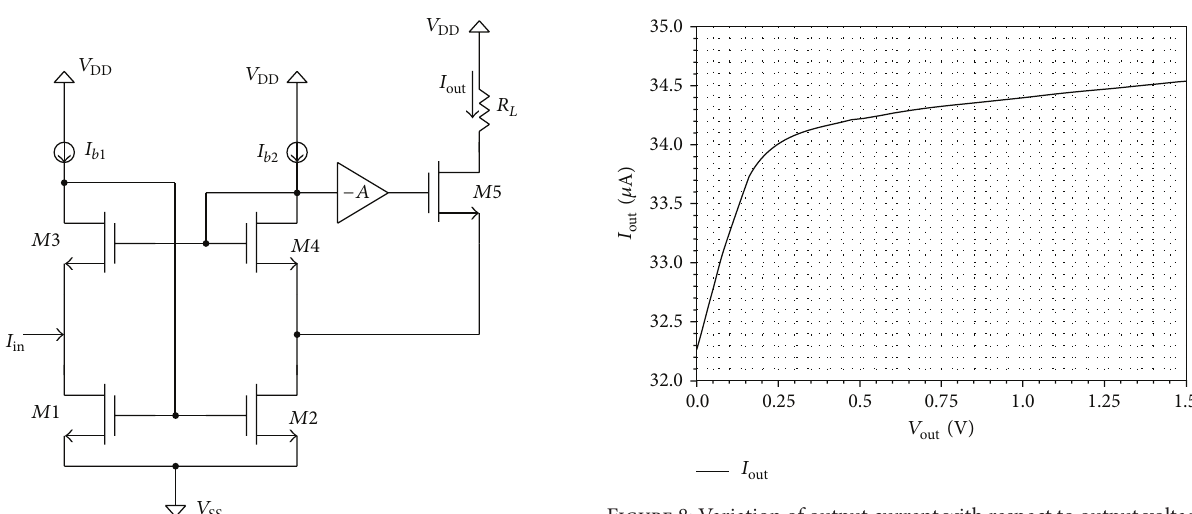
Figure 8: Variation of output current with respect to output voltage of LVCCM.